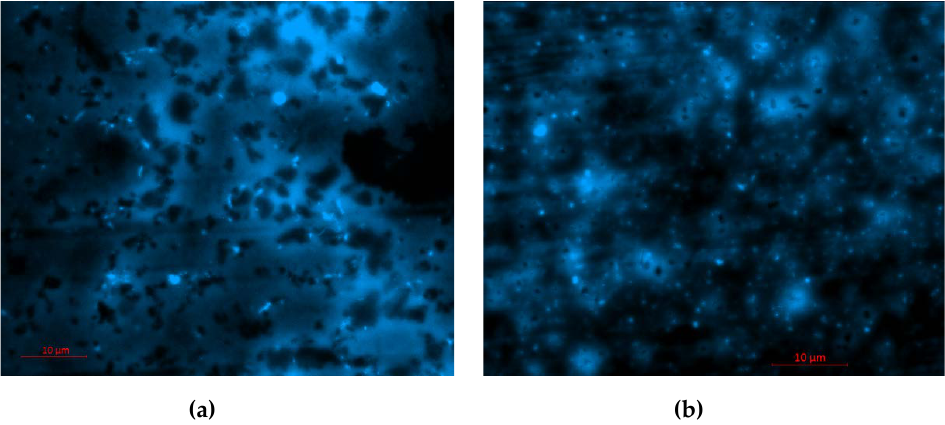
Figure 1. Epifluorescence image of DAPI (4 ′ ,6-diamidino-2-phenylindole) stained Pb concentrate ( a ) and Zn rougher concentrate ( b ) samples showing the presence of microorganisms in flotation. Cells appear as bright blue spots and leftover stain as paler blue especially around black mineral particles. Scale bar is 10 µm.